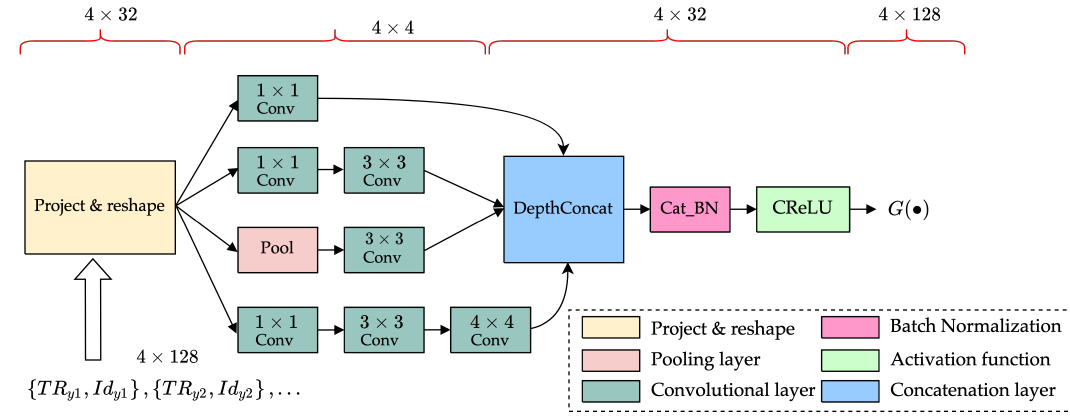
Figure 9. The detailed structural setup of the GM in the